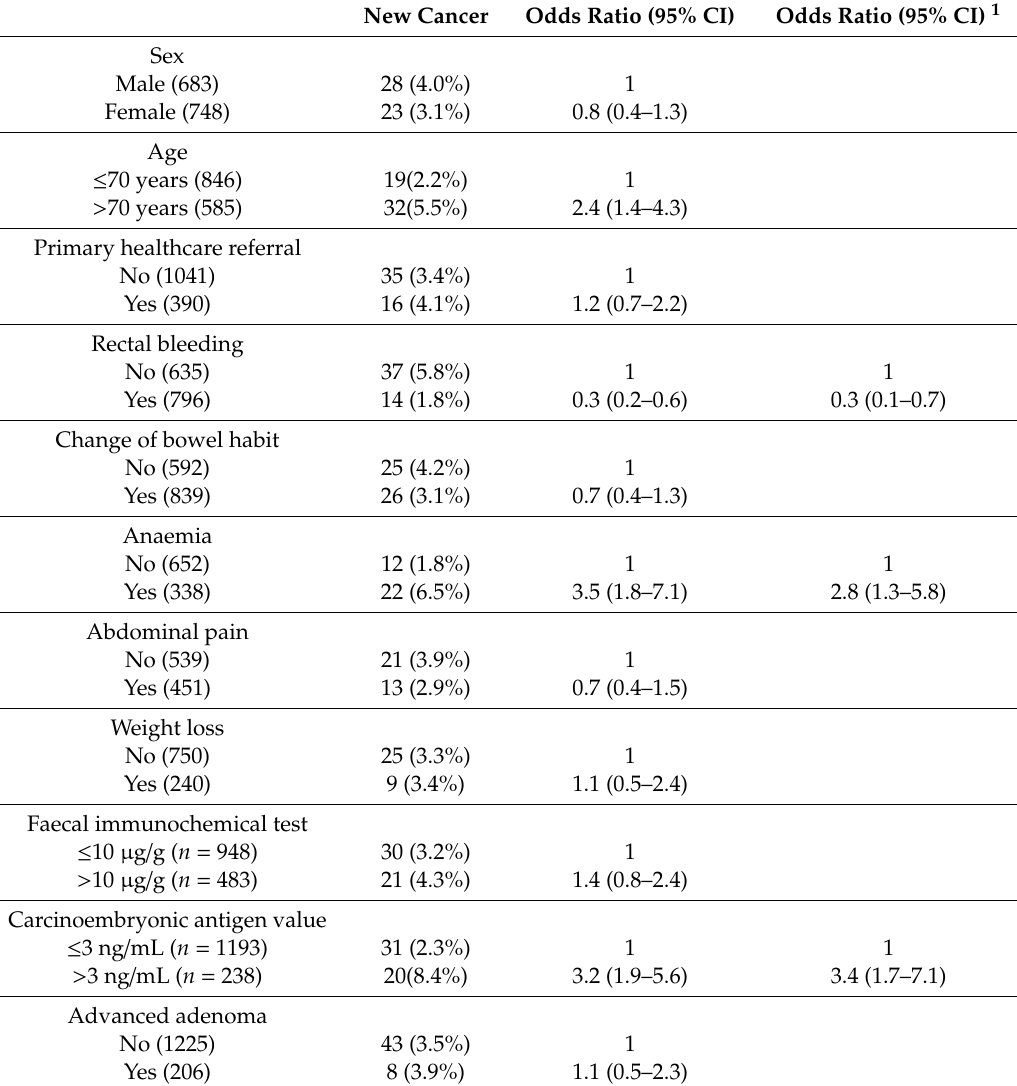
Table 3. Factors associated with cancer detection the first year after baseline